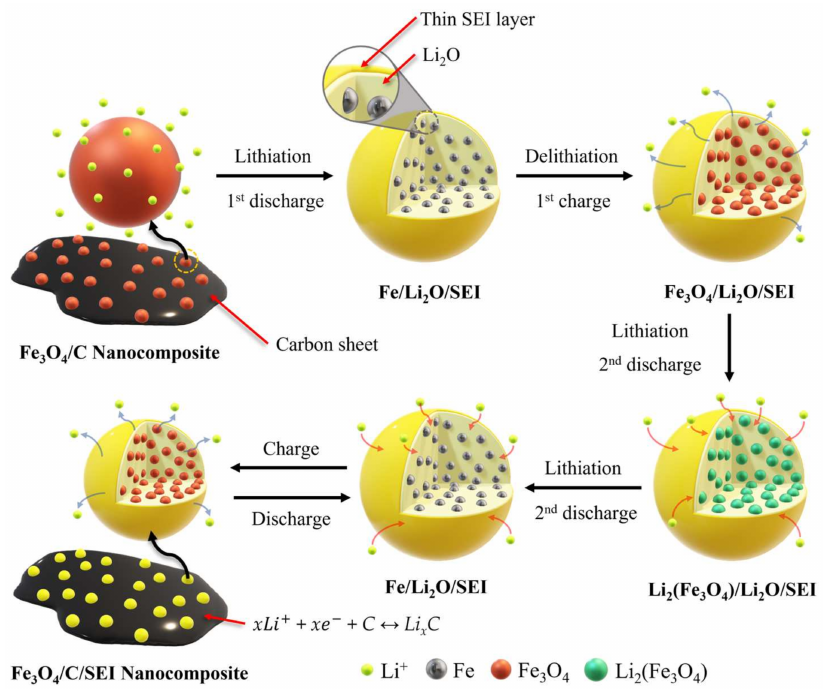
Figure 8. Schematic model depicting the phase evolution of Fe 3 O 4 /C nanocomposite electrode during battery